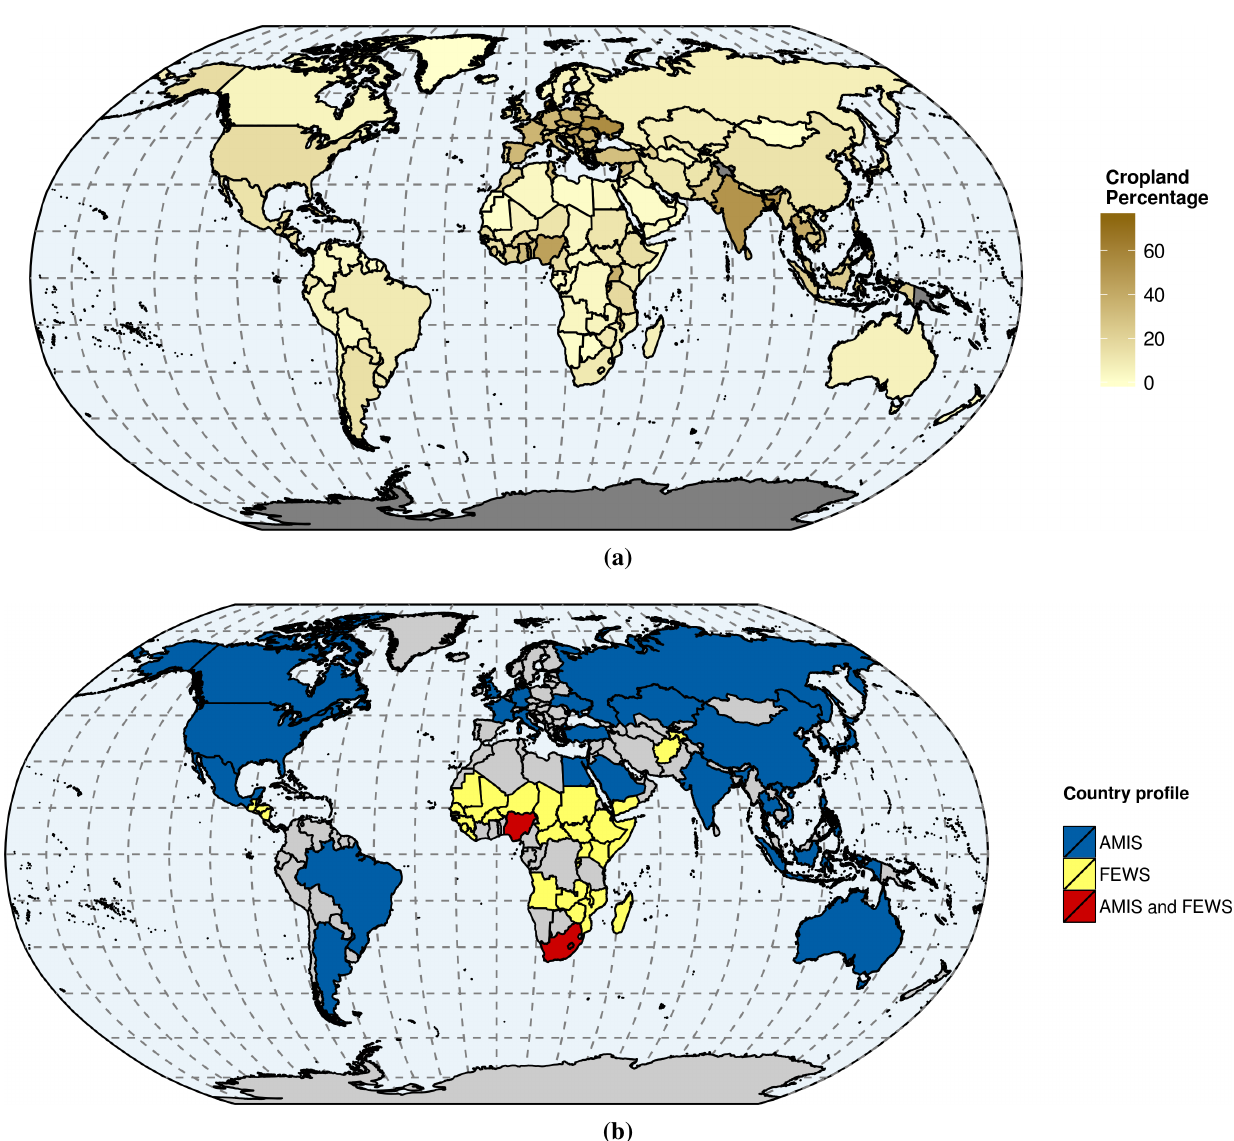
Figure 5. National-level agricultural profiles: ( a ) Percentage of cropland (FAO) and ( b ) FEWS and AMIS countries’ distribution. The percentage of cropland and belonging to the major agricultural commodity producers (Agriculture Market Information System (AMIS) countries) and/or to the countries at risk from a food security point of view (Food Early Warning System (FEWS)) further support the effort’s prioritization. As an example, Sahelian countries are characterized by a high priority index and considered as countries at risk. Cropland mapping efforts appear critical to update the cropland information in this